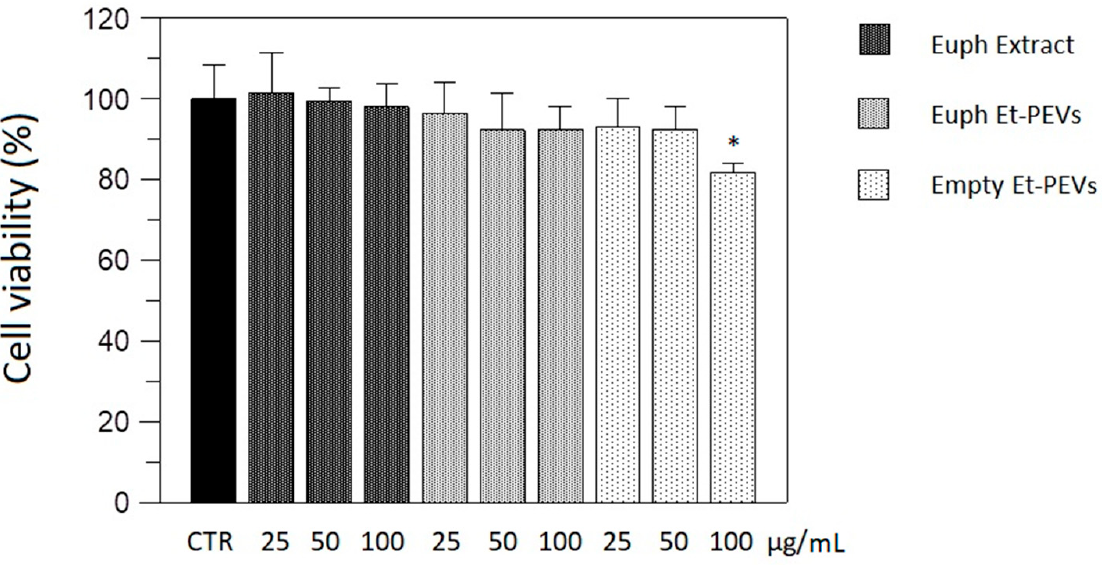
Figure 2. Effect of E. characias extract, in ethanol solution and in Et-PEVs, and empty Et-PEVs, on the viability of B16F10 melanoma cells. * indicates statistical difference vs CTR ( p -value = 0.03).